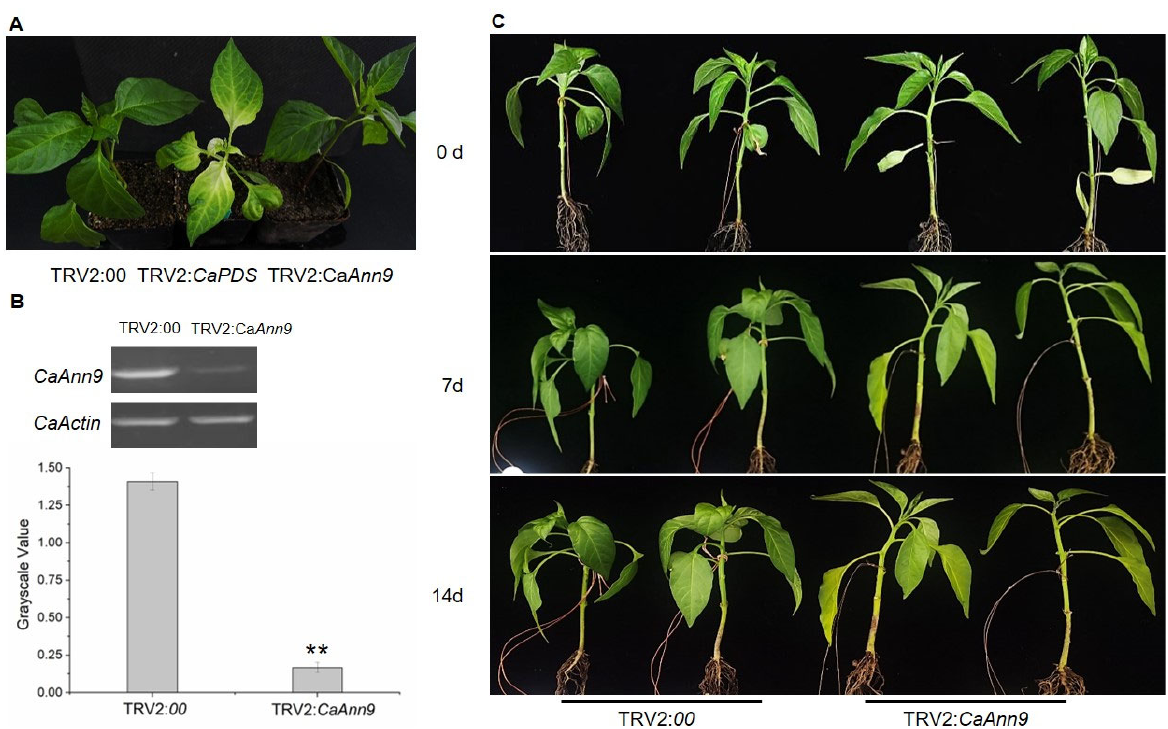
Figure 7. CaAnn9 silenced in pepper decreased tolerance to salt stress. ( A ) The phenotype of CaAnn9 -silenced seedlings. Photographs were taken 40 days post-infiltration. TRV2: CaPDS was used as a positive control vector. TRV2: 00 was used as a control vector. ( B ) Silencing efficiency of CaAnn9 in CaAnn9 -silenced plants. Expression of CaAnn9 in CaAnn9 -silenced plants. RT-PCR analyses of the expression of CaAnn9 are shown in the three independent plants. CaActin was used as an internal control. Grayscale value was measured by ImageJ1.51 j8 [24]. ** Represents significant differences at p ≤ 0.01. Error bars represent SD values of five bands. ( C ) Phenotype of CaAnn9 -silenced and control plants under 200 mM NaCl. The CaAnn9 ‐ silenced and control seedlings were treated with 200 mM NaCl for 7 d and 14 d.